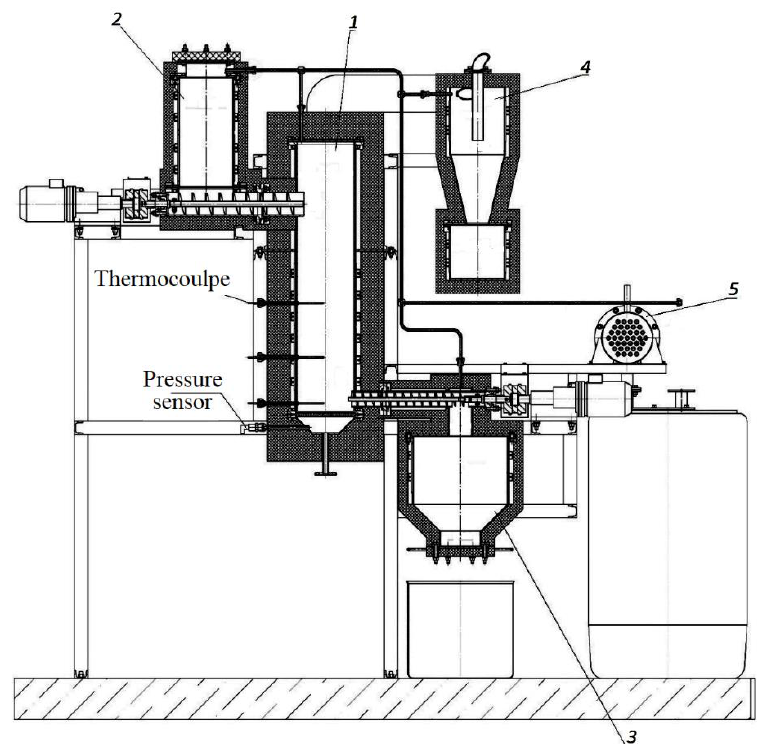
Figure 4. Scheme of installation for the torrefaction of sunflower husks in a fluidized bed in an environment of superheated steam .